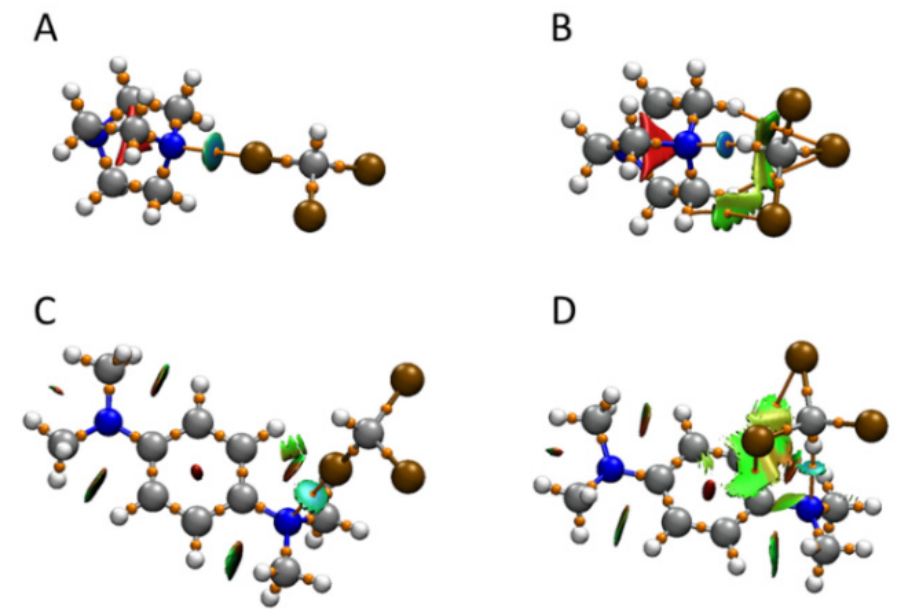
Figure 6. Superposition of the results QTAIM and NCI analyses onto the structures of the XB complexes of CHBr 3 with DABCO ( A ) and TMPD ( C ) and HB complexes with DABCO ( B ) and TMPD ( D ). The bond paths and critical (3, − 1) points (from QTAIM) are shown as orange lines and spheres, respectively, and blue-green discs indicate areas of bonding interactions (from NCI).